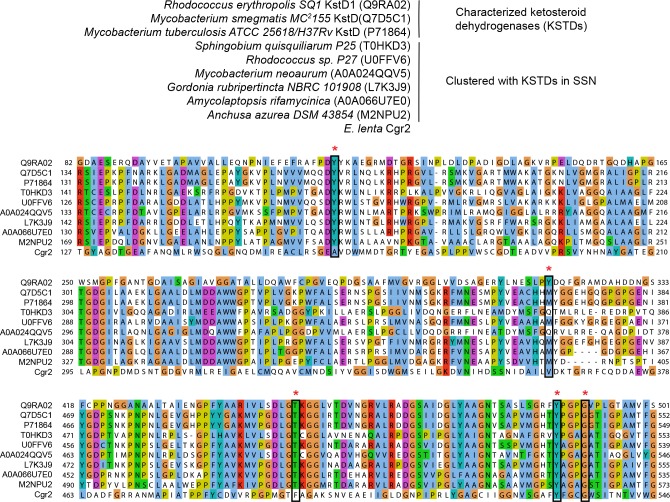
Multiple sequence alignment of ketosteroid dehydrogenases.UniProtKB ID numbers are shown in parentheses. Active site residues (marked with an asterisk) were conserved in characterized ketosteroid dehydrogenases and clustered proteins from the sequence similarity network. Two residues involved in substrate binding and activation were conserved in Cgr2 (Y532, G536).